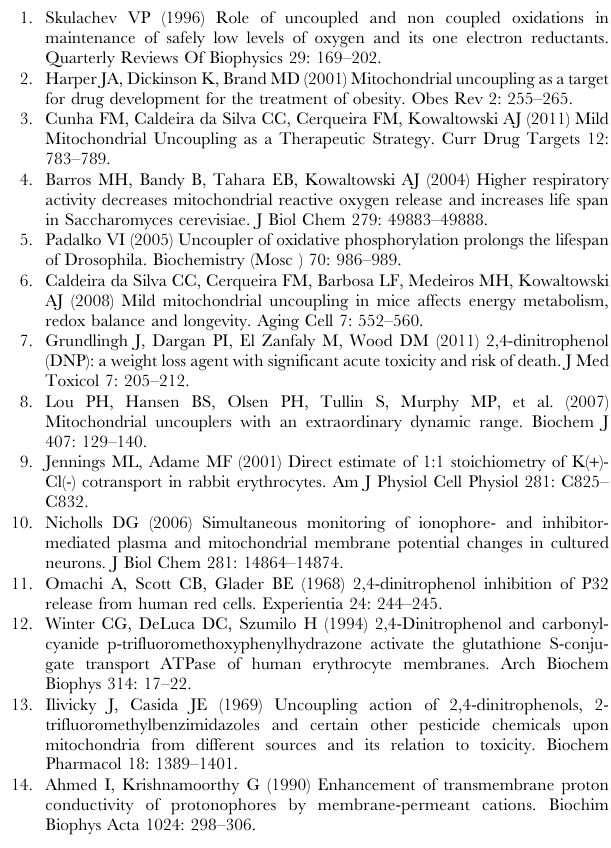
Figure S1 FCCP and C 12 TPP do not display synergistic inhibition of the increase in biomass of S. cerevisiae .